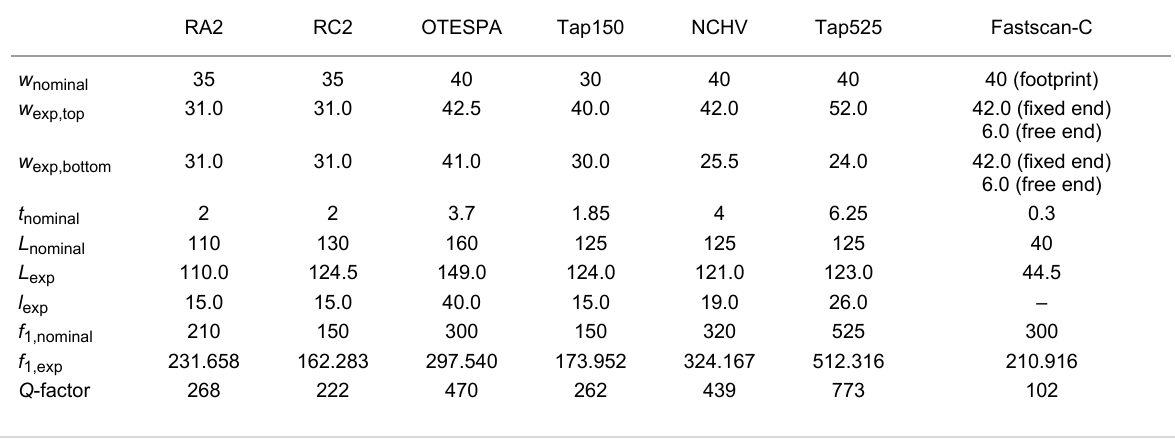
Table 1: Nominal and experimentally determined geometric dimensions (width, w , thickness, t , full length, L , and length of picketed end, l , all given in μ m), fundamental frequency, f (kHz), and Q -factor of the cantilevers studied.